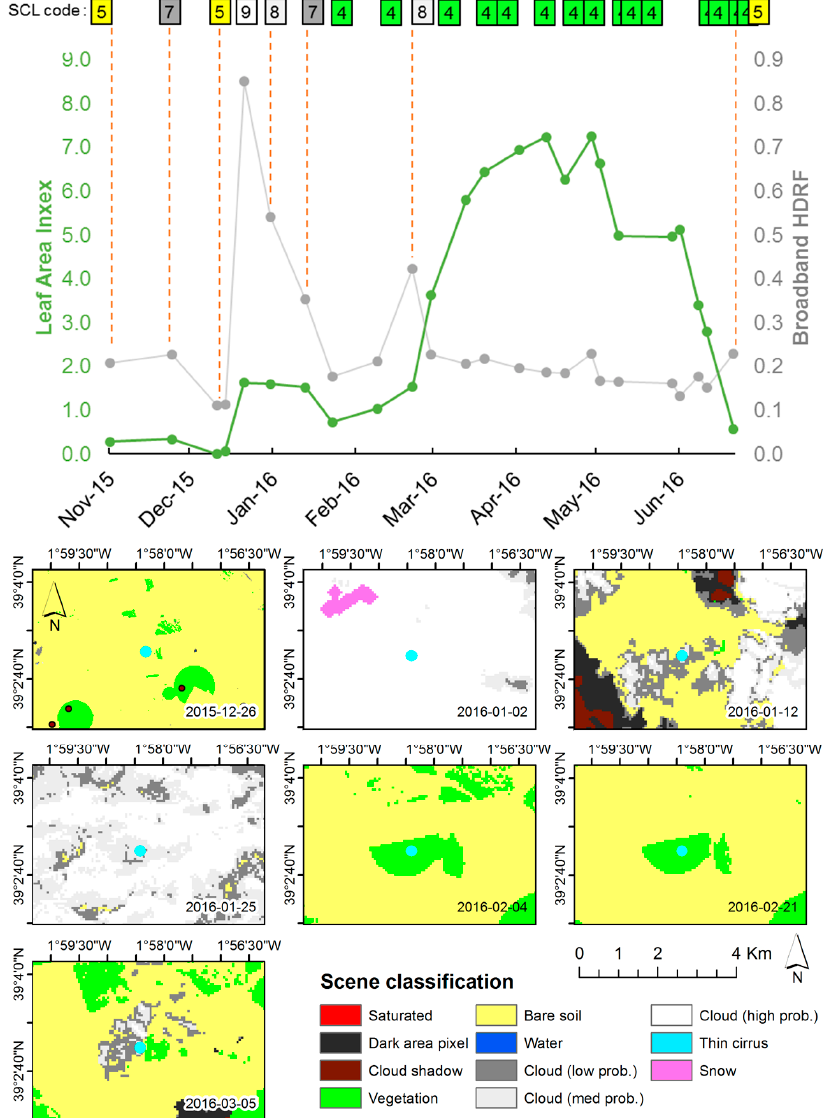
Figure 12. Time series of LAI and broadband HDRF for an exemplary cropland pixel in Barrax, Spain (588,916; 4,322,882, UTM/WGS84). The numbers on top of the chart indicate the scene classification code (Bare soil = 5; Cloud cover with low to high probability: 7–9). All other points are classified as vegetation (4, in green).